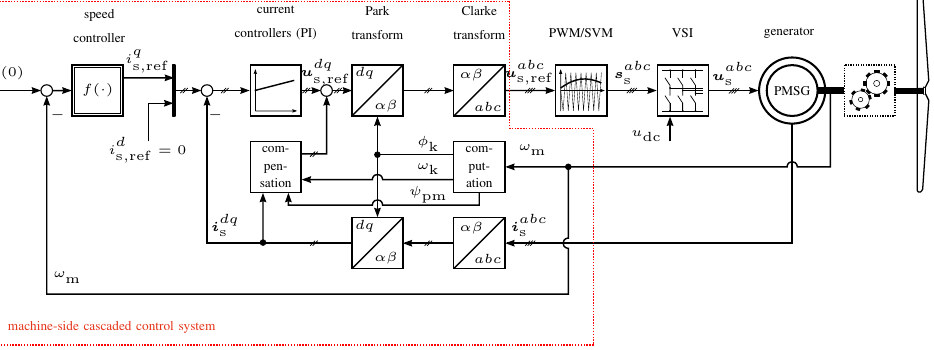
Figure 7. Machine-side cascaded control system (Regime II).